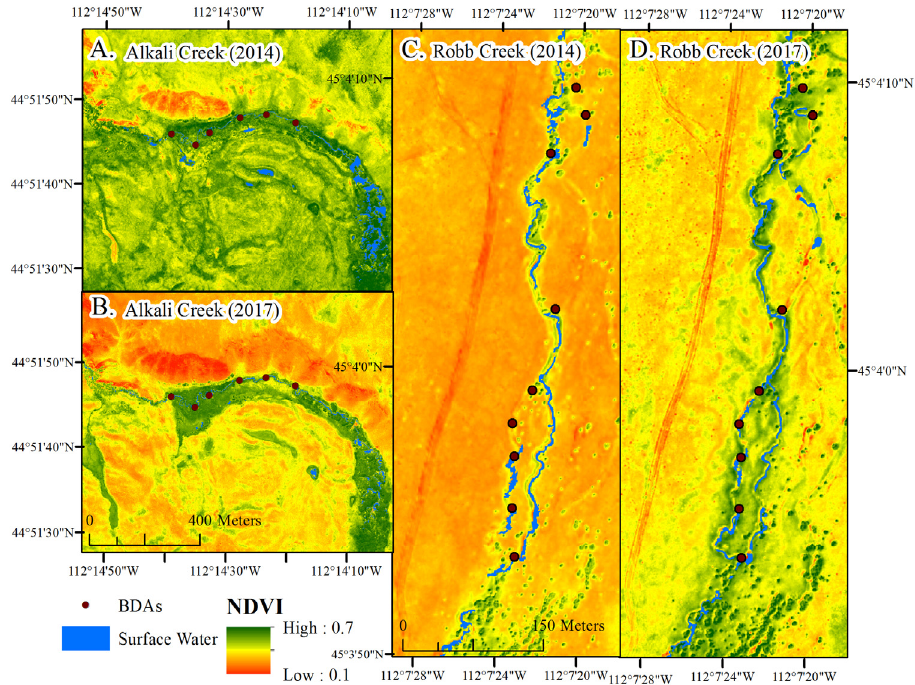
Figure 10. Change in riparian greenness along ( A ) Alkali Creek (2014), ( B ) Alkali Creek (2017), ( C ) Robb Creek (2014), and ( D ) Robb Creek (2017) from pre- to post-restoration conditions. NDVI: Normalized difference vegetation index; BDAs: beaver dam analogues.